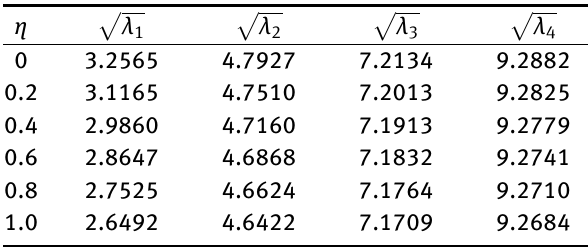
Table 17: Frequency parameter uniform